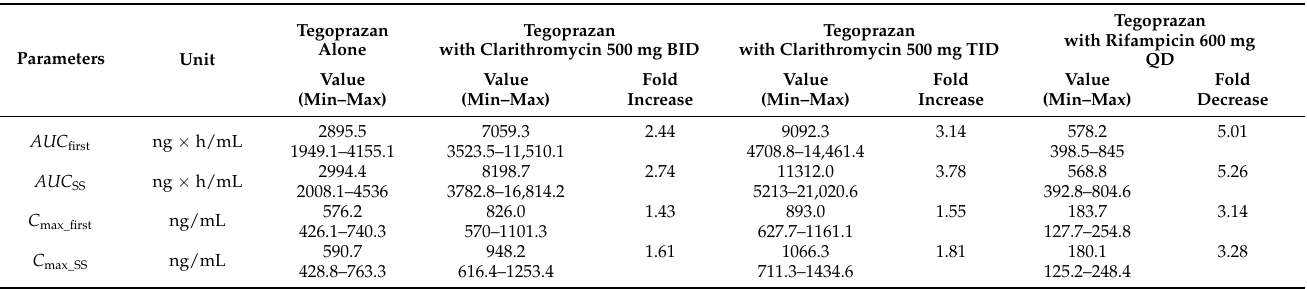
Table 2. Predicted PK parameters of tegoprazan following oral administration of tegoprazan (50 mg, QD) with CYP3A4 perpetrators.